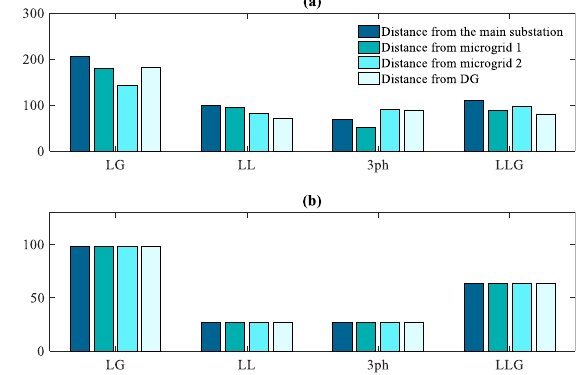
Fig. 7 KNN outputs error of estimated fault distances from all sources, for 20 randomly selected testing data